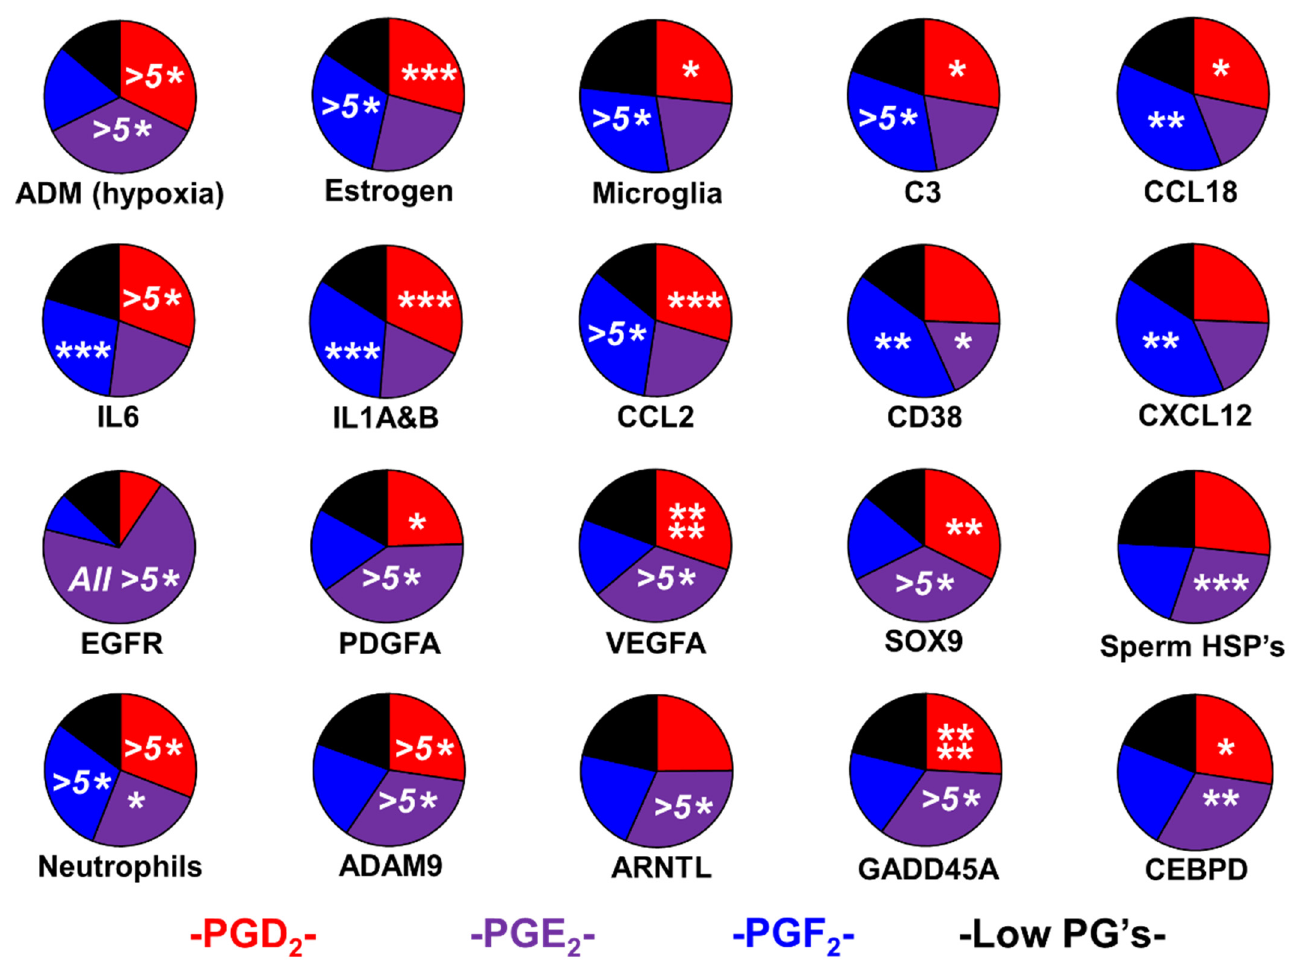
Figure 4. The main drivers and outputs for the four prostaglandin phenotypes are ‘Low PG’, PGD 2 , PGF 2 , and PGE 2 . The median transcripts of genes or gene baskets are displayed as color-coded pie charts with t -test significance levels represented by asterisks (*), p < 0.05 *, p < 0.01 **, p < 0.005 ***, p < 0.001 ****, and p < 0.0001 (5 * ) . Hypoxia-regulated gene ADM shows that the PGD 2 and PGE 2 groups are hypoxic, while the PGF 2 and ‘Low PG’ groups are normoxic. The PGD 2 - and PGE 2 -expressing tumors display elevated levels of estrogen signaling markers. Expression of interleukins IL6, IL1A, and IL1B are highly elevated in the PGD 2 and PGF 2 groups. The PGF 2 group has enriched CD38 and CXCL12. The PGE 2 groups show a bias toward the expressions of markers associated with the clas- sical GBM phenotype, stem cell marker SRY-box transcription factor 9 (SOX9), and sperm-associ- ated HSPs. Neutrophil infiltration of these tumors is high in all the prostaglandin-positive groups, but the activated neutrophil marker ADAM9 is only highly elevated in the PGD 2 and PGE 2 groups. PGE 2 -response genes aryl hydrocarbon receptor nuclear translocator-like protein 1 (ARNTL), growth arrest and DNA-damage-inducible protein GADD45 alpha (GADD45A), and CCAAT/en- hancer-binding protein delta (CEBPD) correlate with tumor PGE 2 synthesis. Neutrophil infiltration of the tumors is high in all the prostaglandin-positive groups. However, the expression of ADAM9 (a marker of activated neutrophils [84]) is only significantly elevated in the PGD 2 and PGE 2 groups.